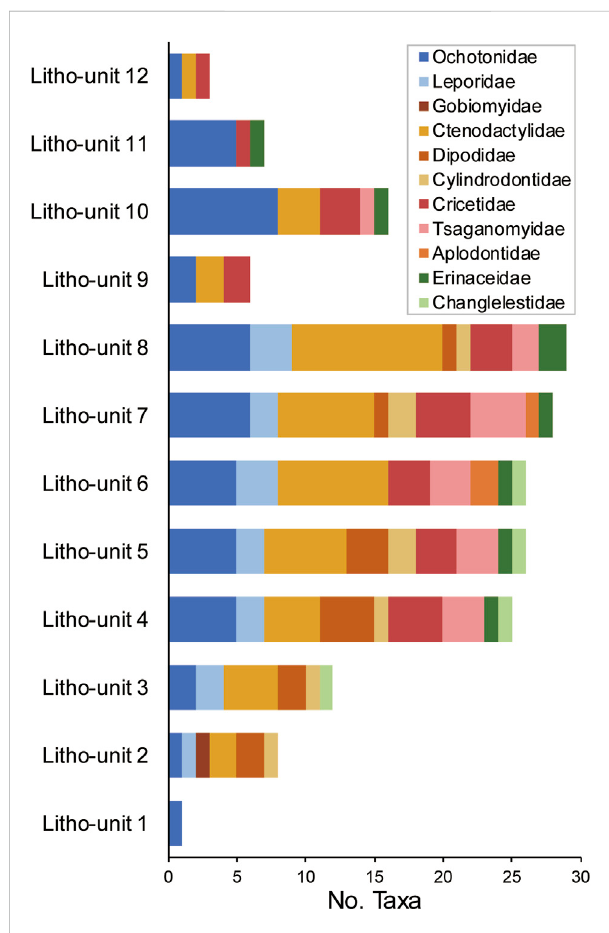
FIGURE 5 Number of small-mammal taxa in different lithostratigraphic units. Lagomorph families are in blue colors, rodent families in warm colors, and insectivore families in green